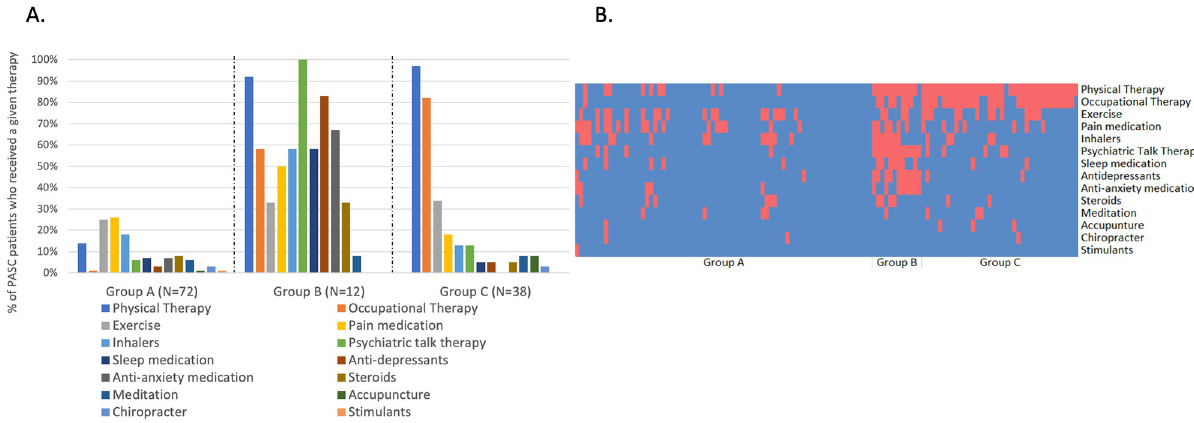
Fig 3. Therapeutic groups among PASC patients (N = 122). Group A received few therapeutic interventions; Group B received several interventions, most notably psychological talk therapy, anti-depressants, anti-anxiety medications and physical therapy; Group C primarily received physical and occupational therapy. Panel A. shows the percent of patients who received a given therapy stratified by therapy group. Colors corresponding to each therapy are shown from left to right in the key. Panel B. shows a heat map where red indicates a given therapy was received and blue indicates that a therapy was not